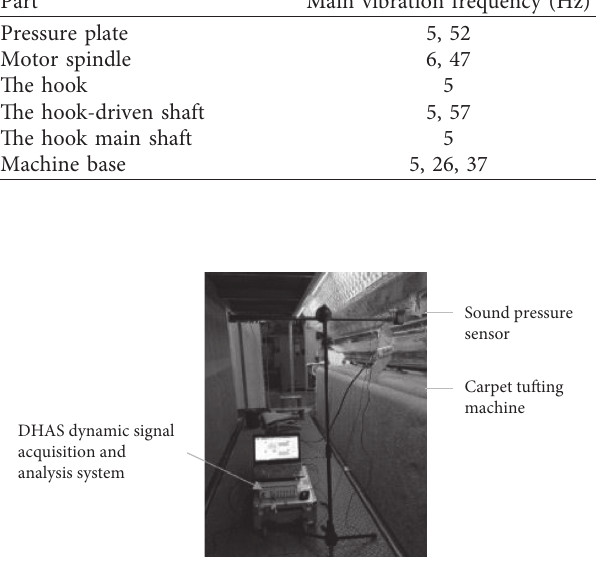
Figure 2: Experimental